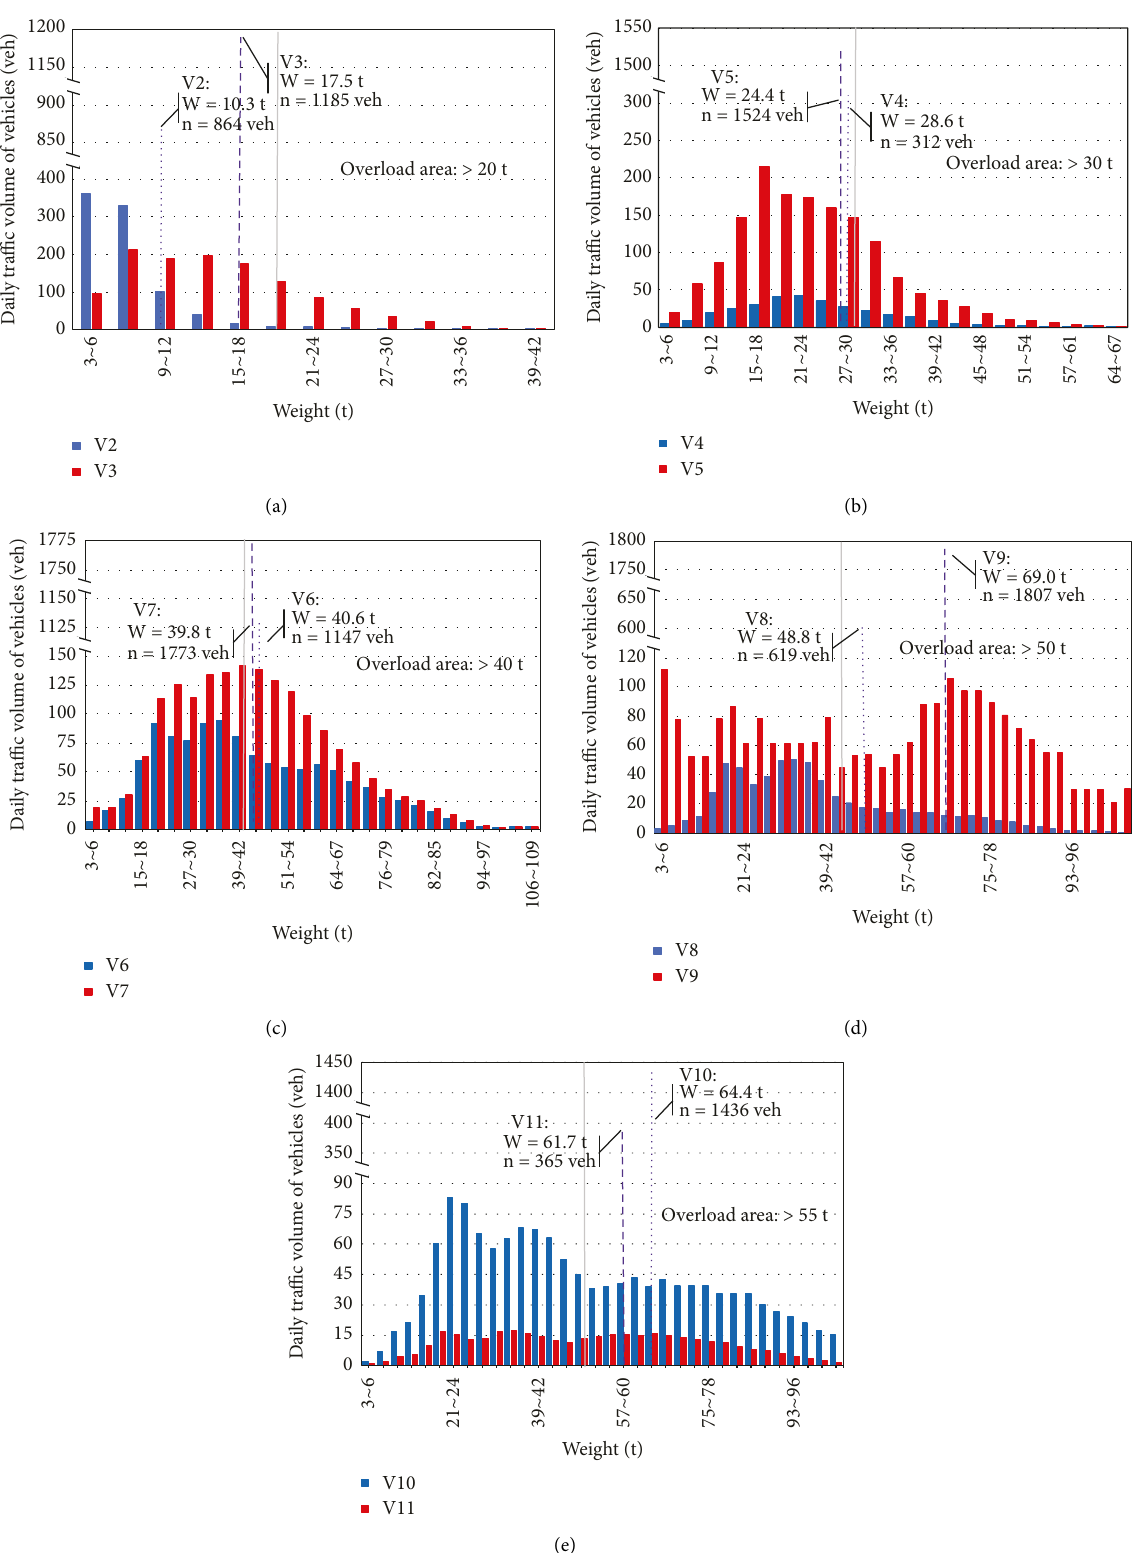
Figure 7: Vehicle mass distribution. (a) Mass distributions of representative two-axle and (b) three-axle vehicles, (c) mass distributions of representative four-axle (d) and five-axle vehicles, and (e) mass distributions of representative six-axle